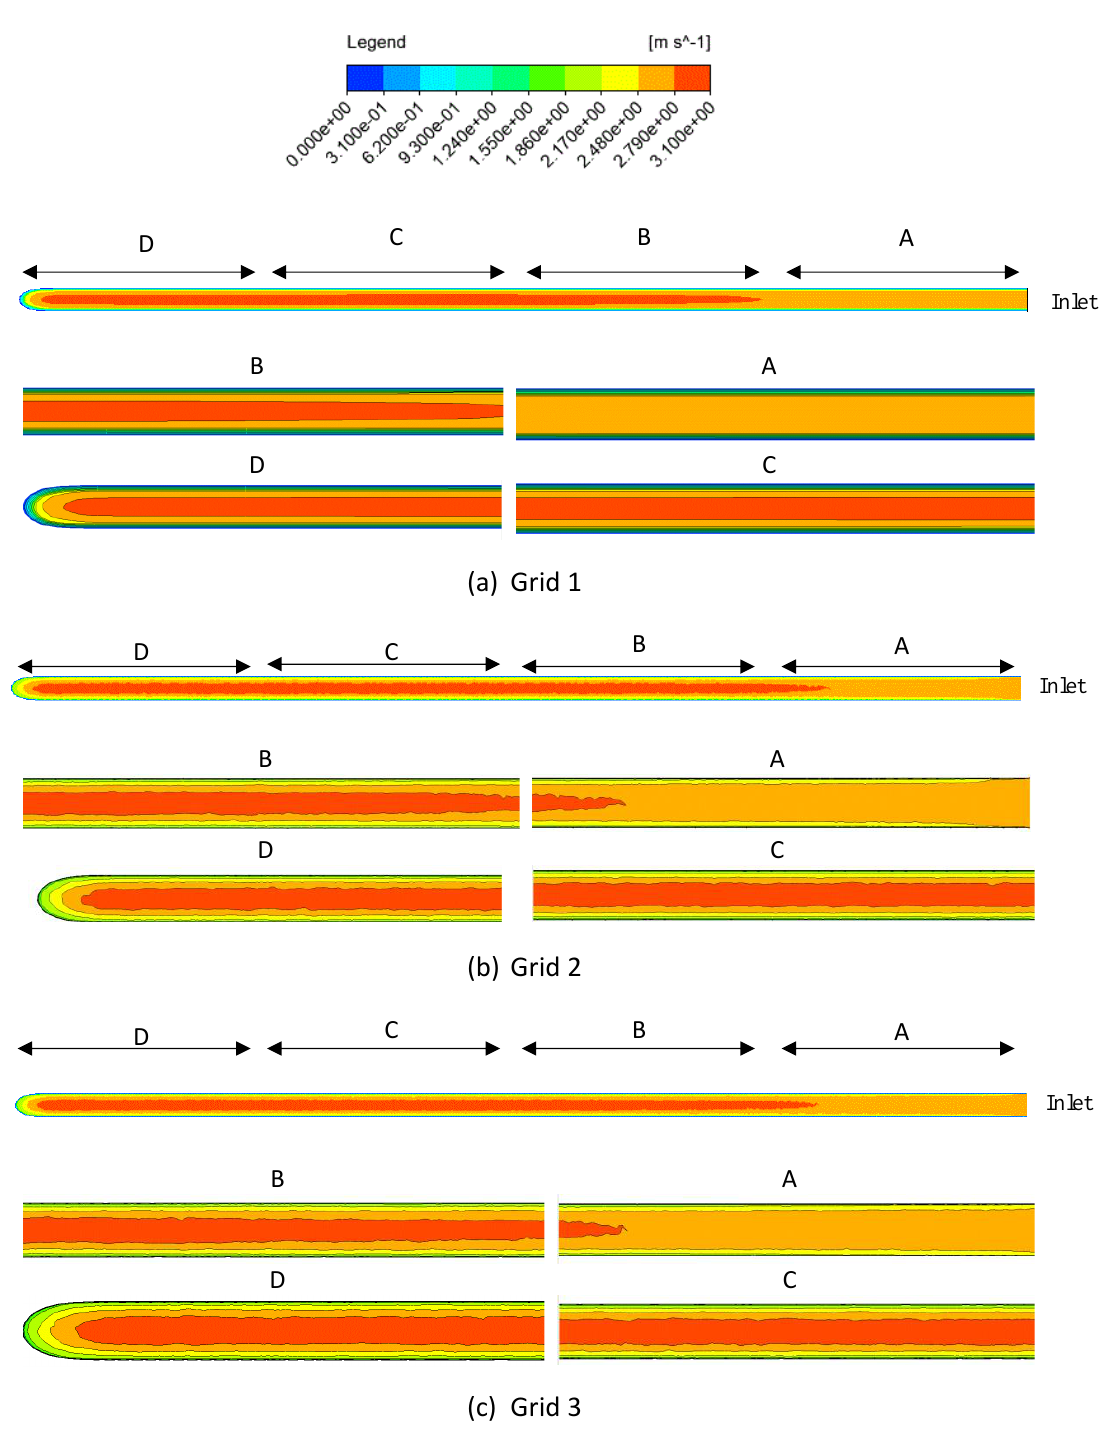
Figure 7. Velocity magnitude contour distribution along the inlet section using water at: Grid 1 ( a ); Grid 2 ( b ); and Grid 3 ( c